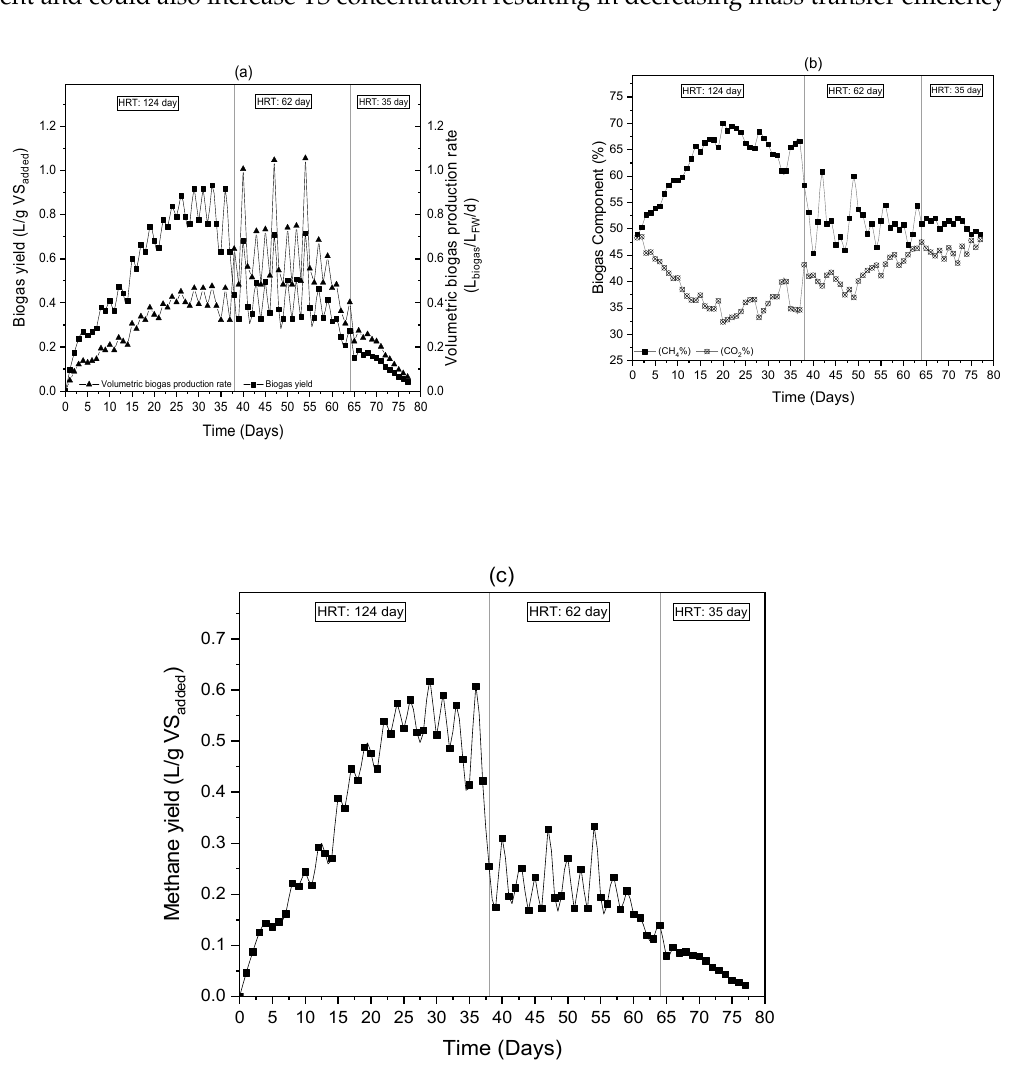
Figure 2. ( a ) Biogas yield and volumetric biogas production rate, ( b ) biogas component, and ( c ) methane yield during anaerobic digestion of food waste.